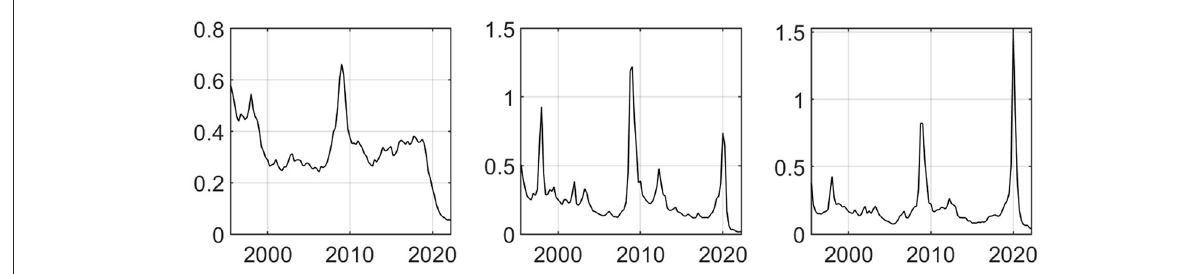
FIGURE3 The desirable mean trend of the extracted non-observable common